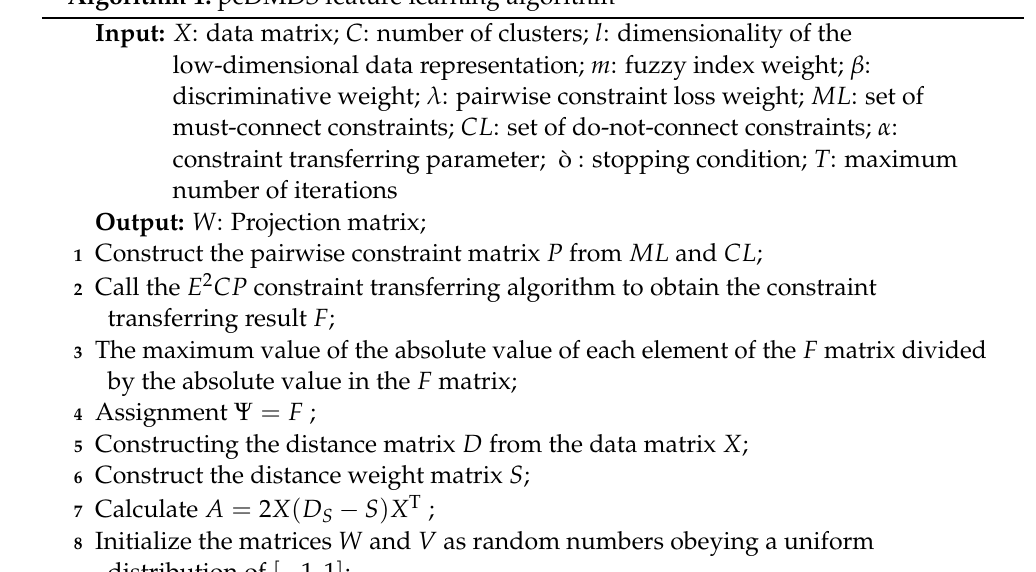
Algorithm 1: pcDMDS feature learning